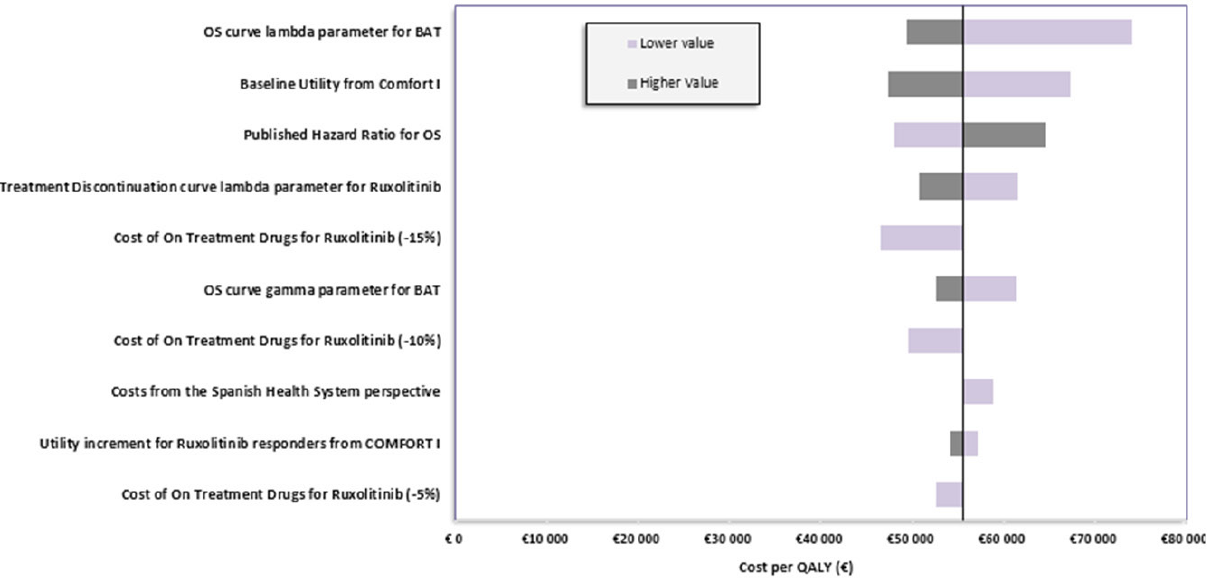
Figure 3. Cost-effectiveness Scatterplot (Ruxolitinib vs BAT)